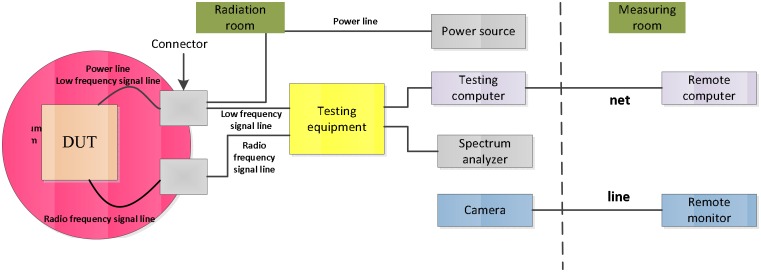
Experimental system.